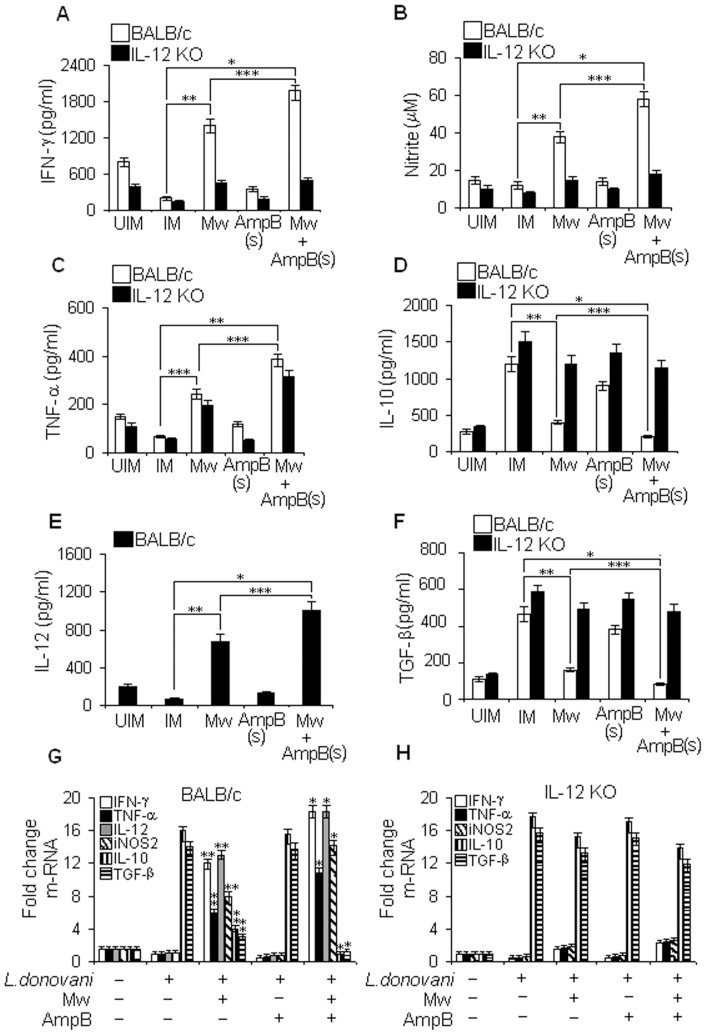

Mw induced Th1 response and NO generation in L. donovani infected BALB/c mice (A–F).Splenocytes from infected and differently–treated mice, as mentioned in figure 6 legend, were isolated on 56 days after infection, plated aseptically (2×105 cells/well), and stimulated with 10 µg/ml soluble leishmanial antigen (SLA) for 48 h. Interferon γ (IFN- γ) (A), nitric oxide (B), Tumor necrosis factor α (TNF-α) (C), Interleukin 10 (IL-10) (D) Interleukin 12 (IL-12) (E) and Tumor growth factor β (TGF- β) (F) from the culture supernatants of the indicated treatment groups were determined by enzyme-linked immunosorbent assay and the Nitric Oxide Colorimetric Assay kit, respectively. Real-Time polymerase chain reaction (PCR) analysis was performed from similar experimental sets to determine proinflammatory (IFN-γ, IL-12p70, TNF-α), anti-inflammatory cytokines (IL-10, TGF-β) and iNOS2 mRNA expression (G, H). Results are from three independent experiments. Data are means ± standard deviations of values from 3 independent experiments that yielded similar results *P<0.001, **P<0.01 compared with infected mice and ***P<0.05 compared with Mw treated infected mice; paired two-tailed Student’s t-test.